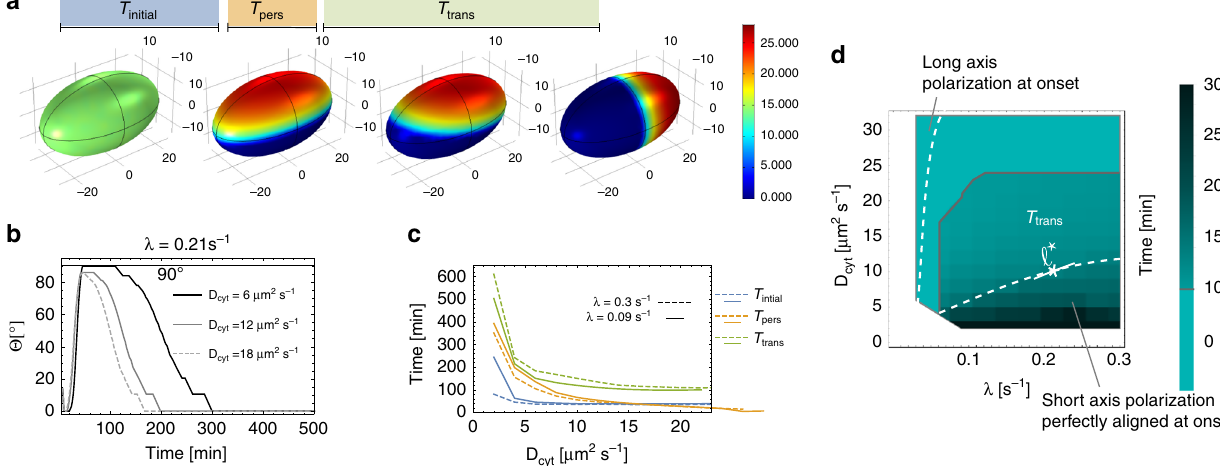
Fig. 6 Cell polarisation in three dimensions. a Image series from FEM (Comsol) simulation for D cyt = 6 μ m 2 s − 1 , and reactivation rate λ = 0.21 s − 1 . The series illustrates the different times which are further analysed: the time from the initial aPAR-dominated unpolarised state to the initial short-axis polarisation, T initial ; the time duration of persistent short-axis polarisation, T pers ; and the time the pattern takes to turn from short- to long-axis polarisation, T trans . b The angle Θ of the concentration maximum of membrane-bound A 1 is plotted against simulation time for different D cyt indicated in the graph. c T initial , T pers , T trans plotted as a function of D cyt for λ = 0.09 s − 1 and λ = 0.3 s − 1 . d The magnitude of the transition time from short- to long-axis polarisation, T trans , in D cyt - λ parameter space; a cell was considered to be polarised along the short axis if 90° − 10° ≤ Θ ≤ 90° + 10°. The monochrome cyan-coloured region above the grey line corresponds to a parameter region where there is no short-axis polarisation, but the polarisation axis is aligned along the diagonal or long axis from the beginning. The dashed lines demarcate parameter regimes where the initial polarisation is aligned perfectly with the short axis ( Θ = 90°) or with the long axis, as indicated in the